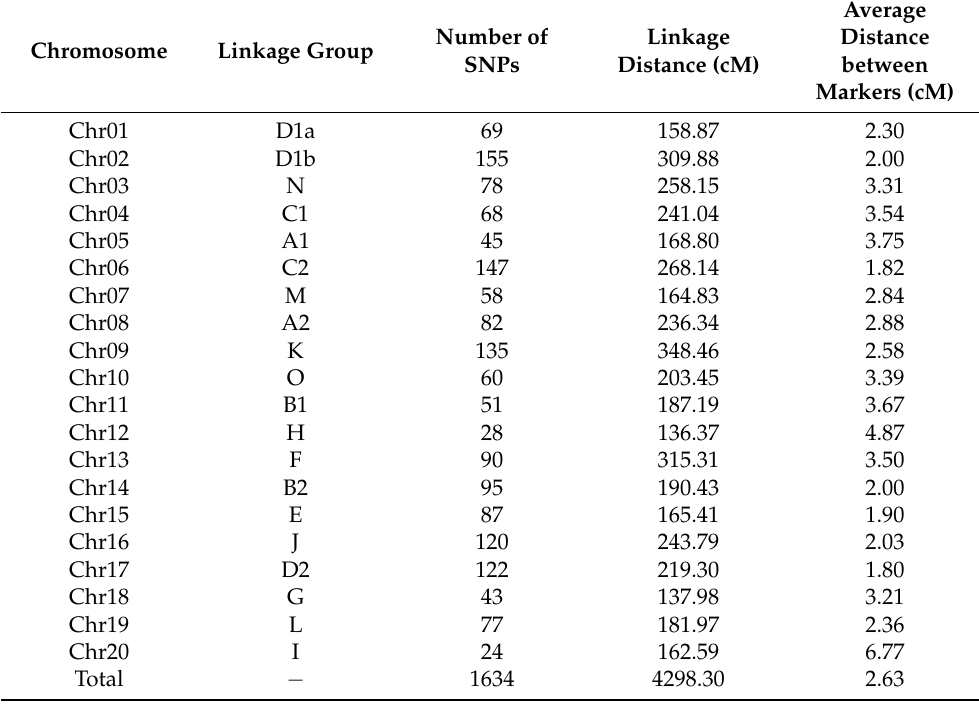
Table 2. Total SNP numbers and linkage distances of chromosomes in F 2